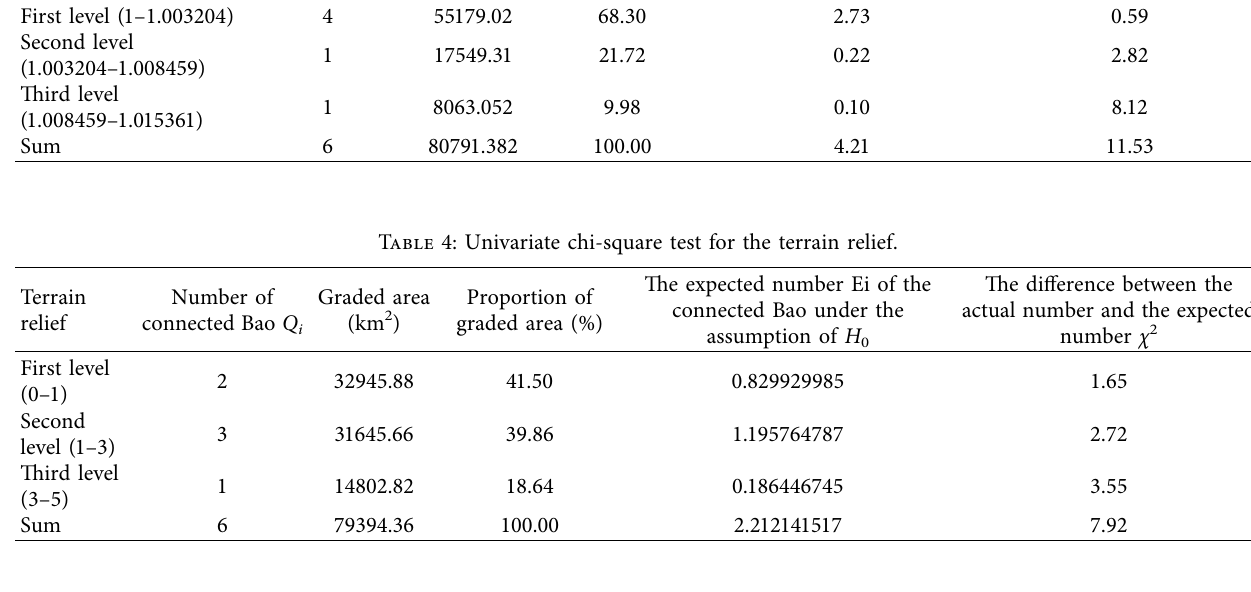
Table 5: Univariate chi-square test for the slope change rate.